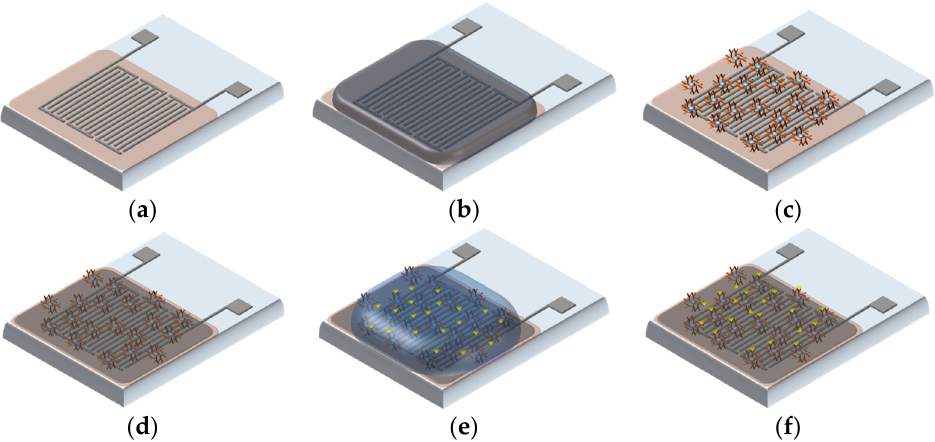
Figure 3. Procedure of antibodies immobilization: ( a ) Coated with 10 μ L glutaraldehyde and incubated with Argon Gas for 2 h; ( b ) Coated with 2 μ L antibody for 1 h; ( c ) Immobilized antibodies; ( d ) 2 μ L of 2% BSA was added and incubated for 30 min; ( e ) Added antigen (10, 5, 2.5, 1.25 mg/L); ( f ) Antibody and antigen interaction.